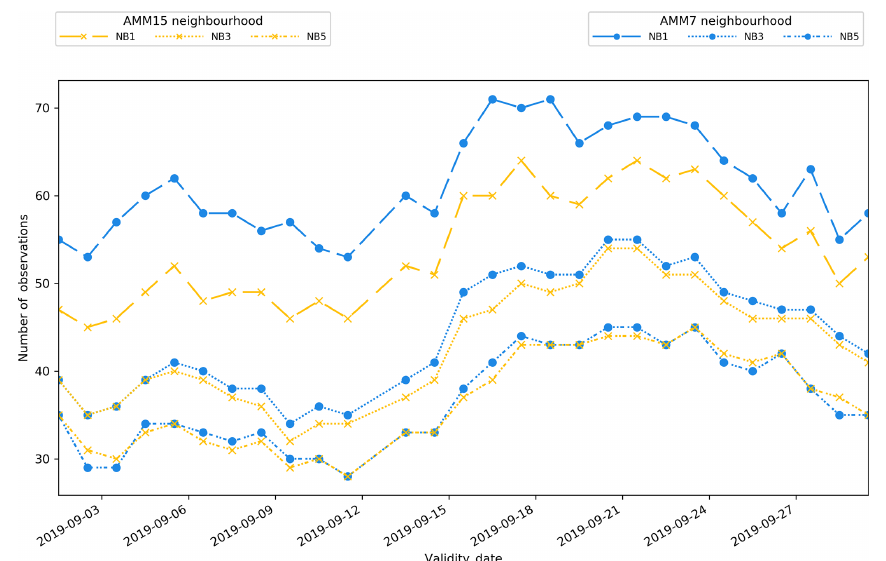
Figure 6. Number of observation sites within NB1, NB3 and NB5 for AMM15 and AMM7. Numbers are those used during September 2019 but represent typical total observations during a month. Matching line styles represent equivalent neighbourhoods.